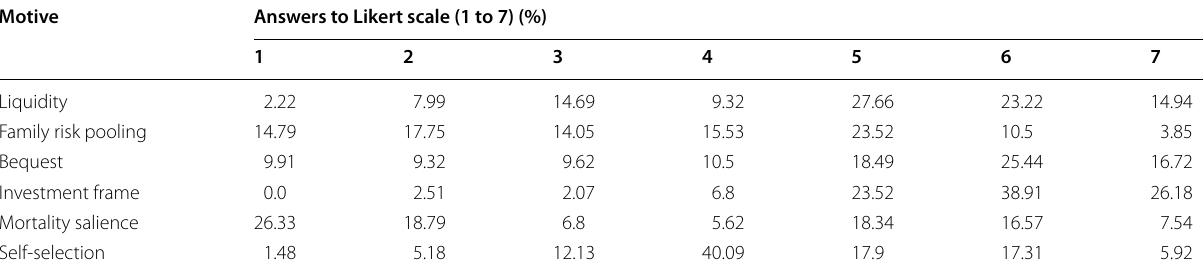
Table 3 Distribution of motive